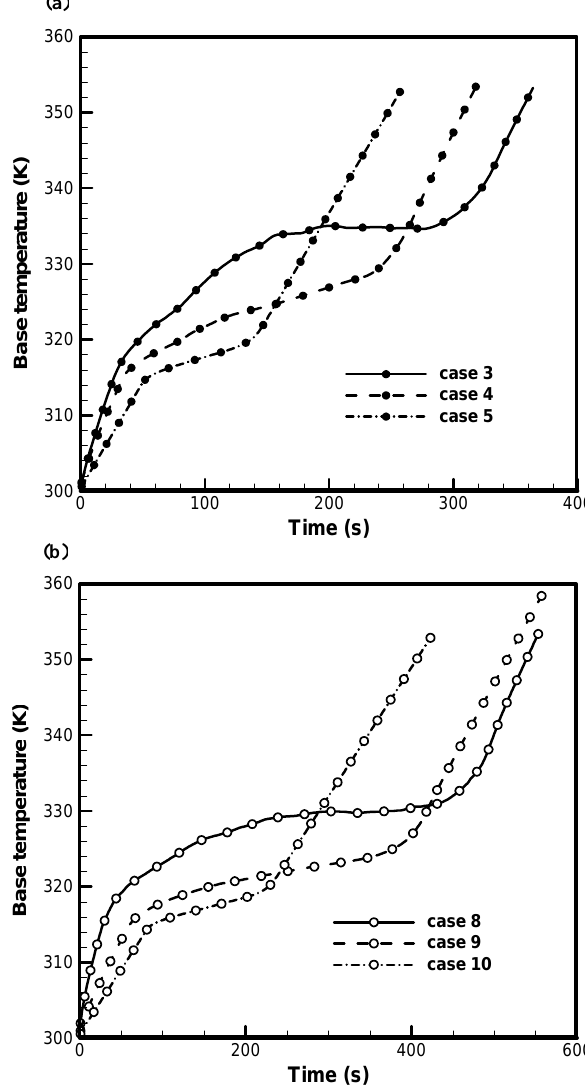
Figure 5. Base temperature evolution with time for different num- bers of fins: (a) various cases for fin height of 15mm and (b) various cases for fin height of